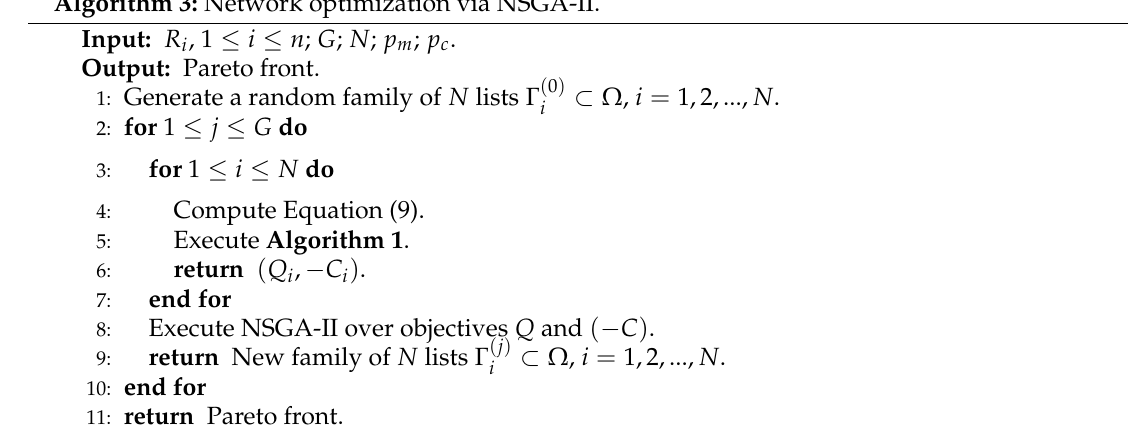
Algorithm 3: Network optimization via